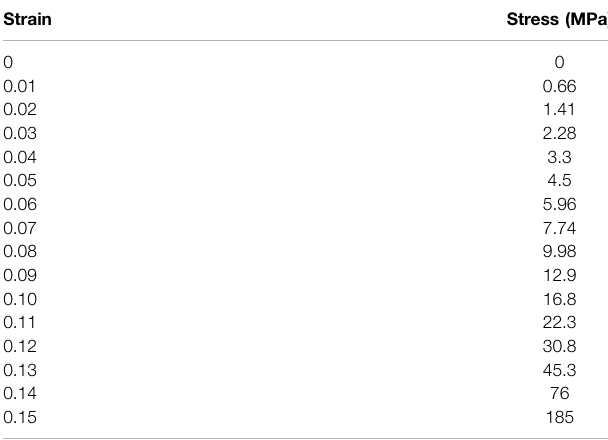
TABLE 2 | Mechanical parameters of the strain-softening model. Shear strain